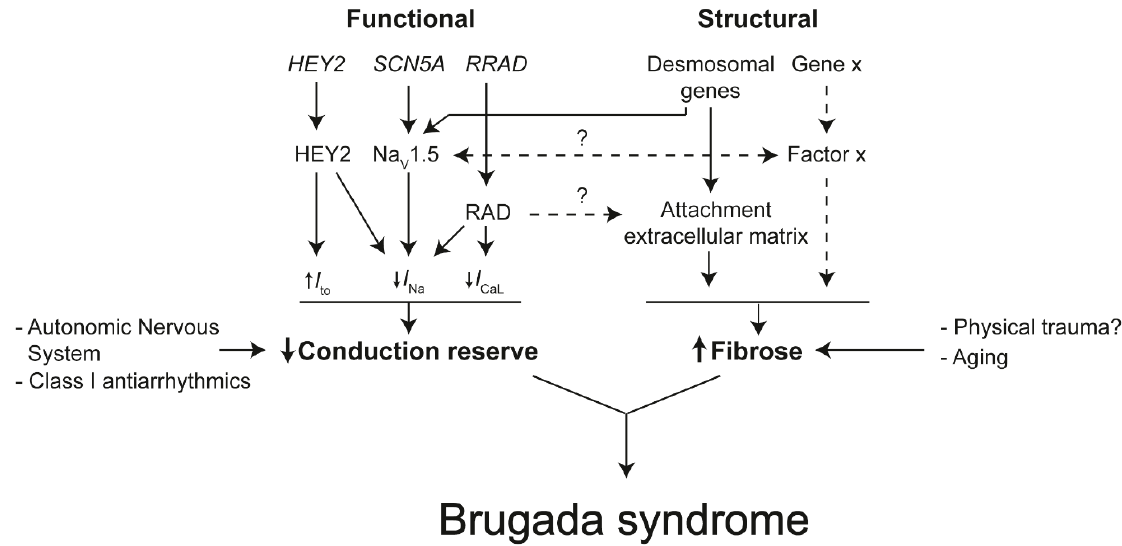
Figure 4. The working hypothesis underlying Brugada syndrome.